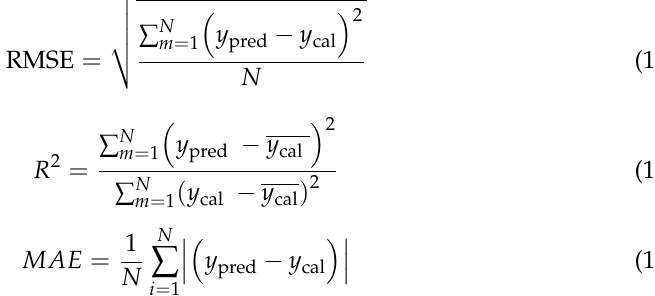
Figure 10. MAE performance comparison results between LSTM and MLNN for the prediction of SM and SEC.